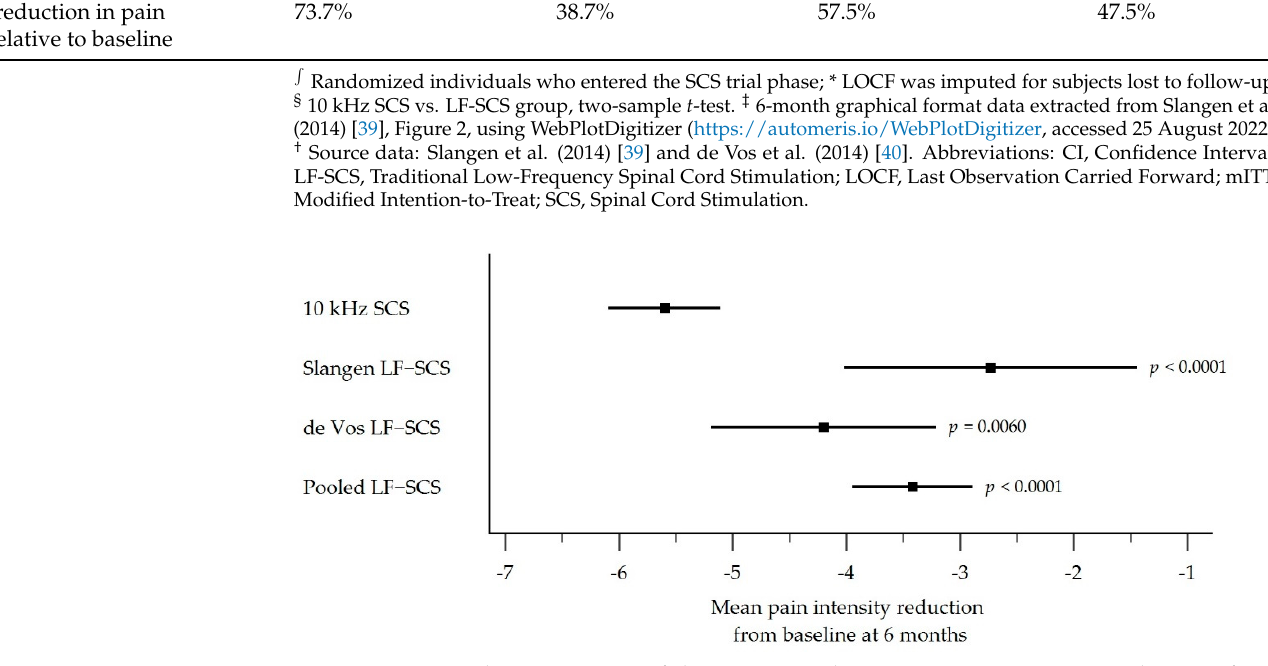
Figure 3. Forest plot comparison of the mITT population mean pain intensity reductions from base- line at 6 months with 95% CI ( p -value is for 10 kHz SCS vs. LF-SCS group). The mITT population